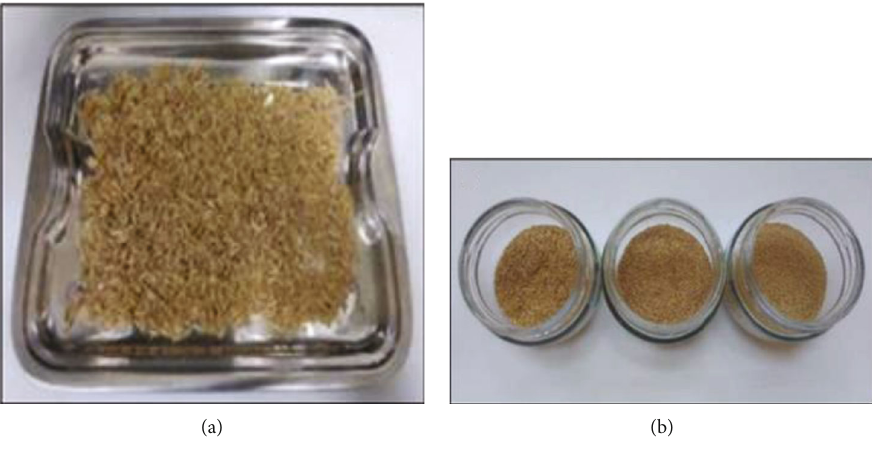
Figure 1: Rice husk dried (a) and sieved